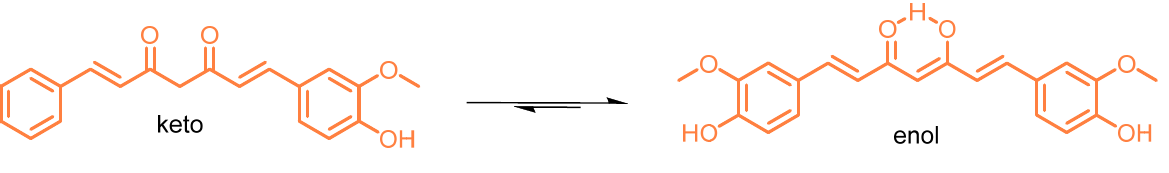
Figure 1. Keto-enol tautomeric forms of curcumin (CUR).